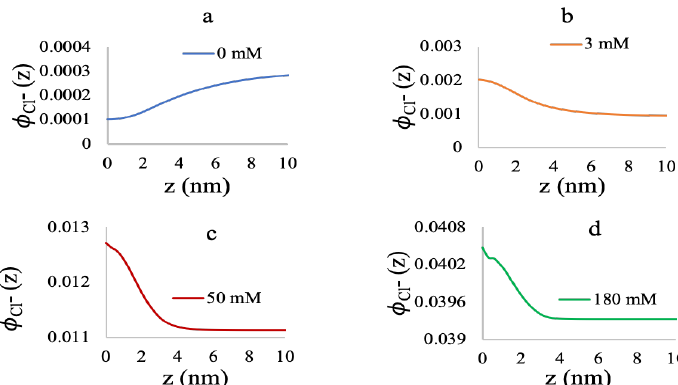
Figure 7. Chloride volume fractions at 0.005 chains/nm 2 for 0 mM ( a ), 3 mM ( b ), 50 mM ( c ), and 180 mM ( d ) MgCl 2 concentrations.